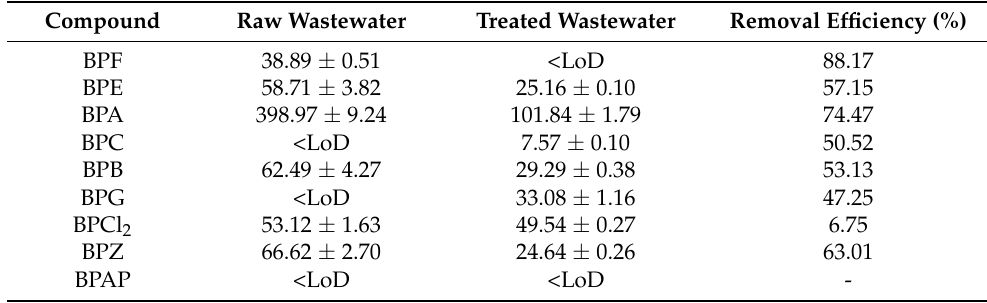
Table 9. Bisphenol concentration (ng/L) in wastewater samples. SD calculated for three repetitions. Compound Raw Wastewater Treated Wastewater Removal Efficiency (%) BPF 38.89 ± 0.51 <LoD 88.17 BPE 58.71 ± 3.82 25.16 ± 0.10 57.15 BPA 398.97 ± 9.24 101.84 ± 1.79 74.47 BPC <LoD 7.57 ± 0.10 50.52 BPB 62.49 ± 4.27